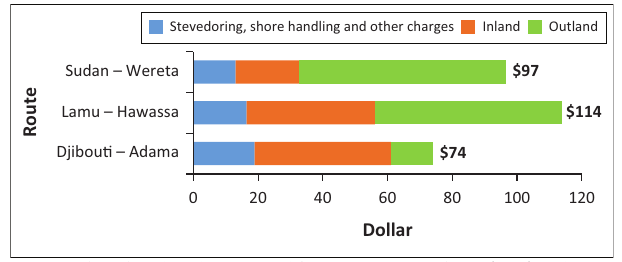
FIGURE 8: Logistics costs for dry bulk imports (per